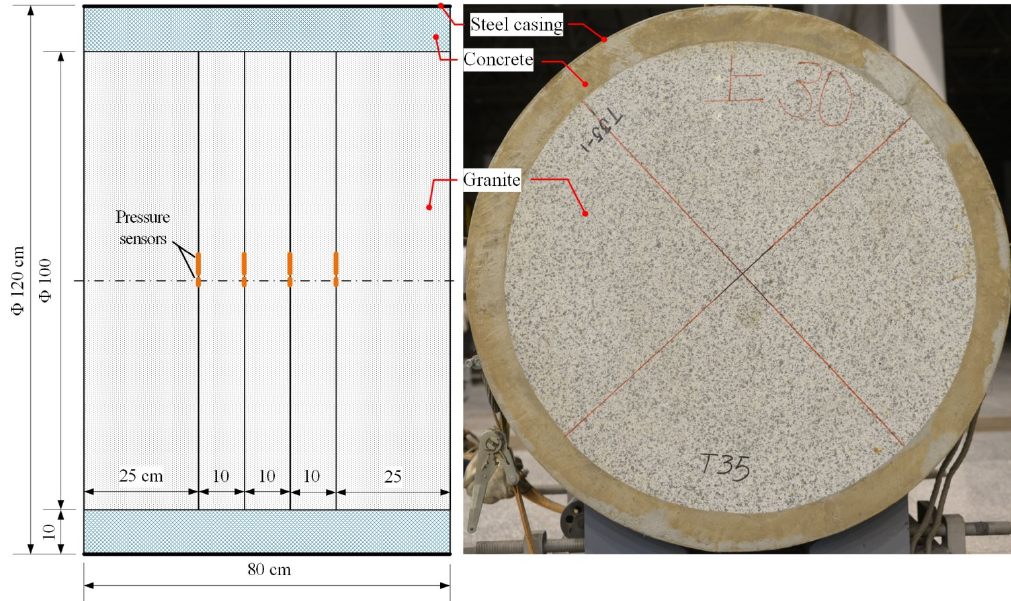
Figure 2. Dimensions and photographs of a target sample.